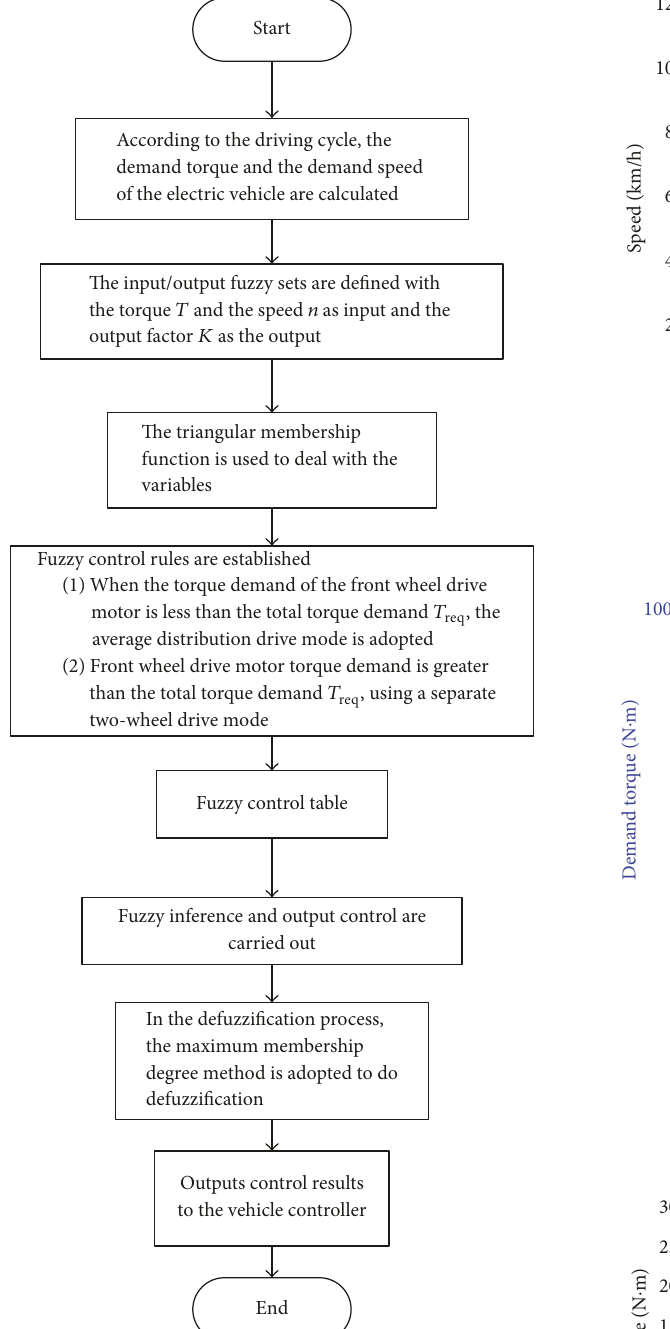
Figure 11: Fuzzy control algorithm to achieve torque distribution process.